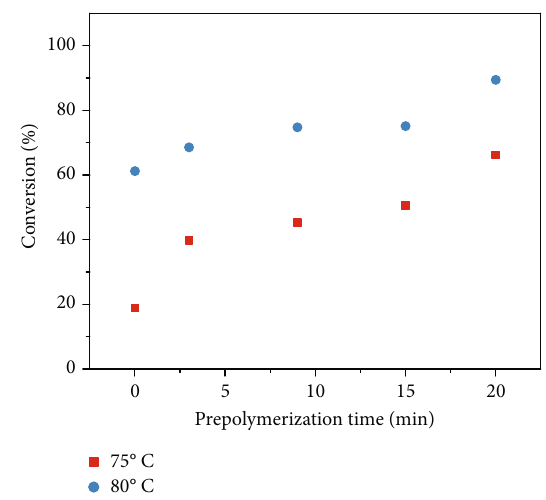
Figure 7: E ff ect of the prepolymerization time on the monomer conversion at 75 and 80 ° C ( W : O = 2 : 1 , t 2 = 20 min, and the concentration of APS was